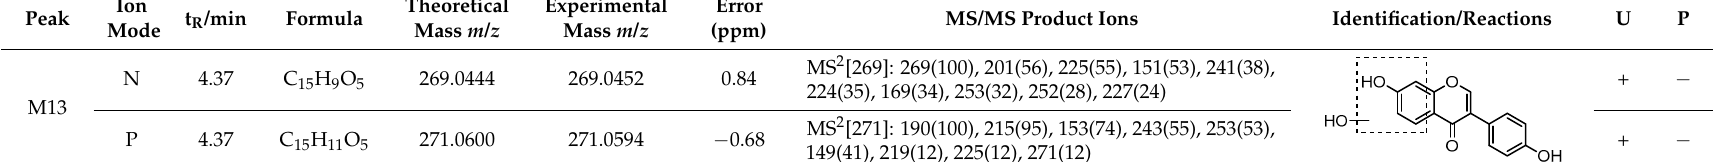
Table 1. Summary of daidzein metabolites in rat urine and